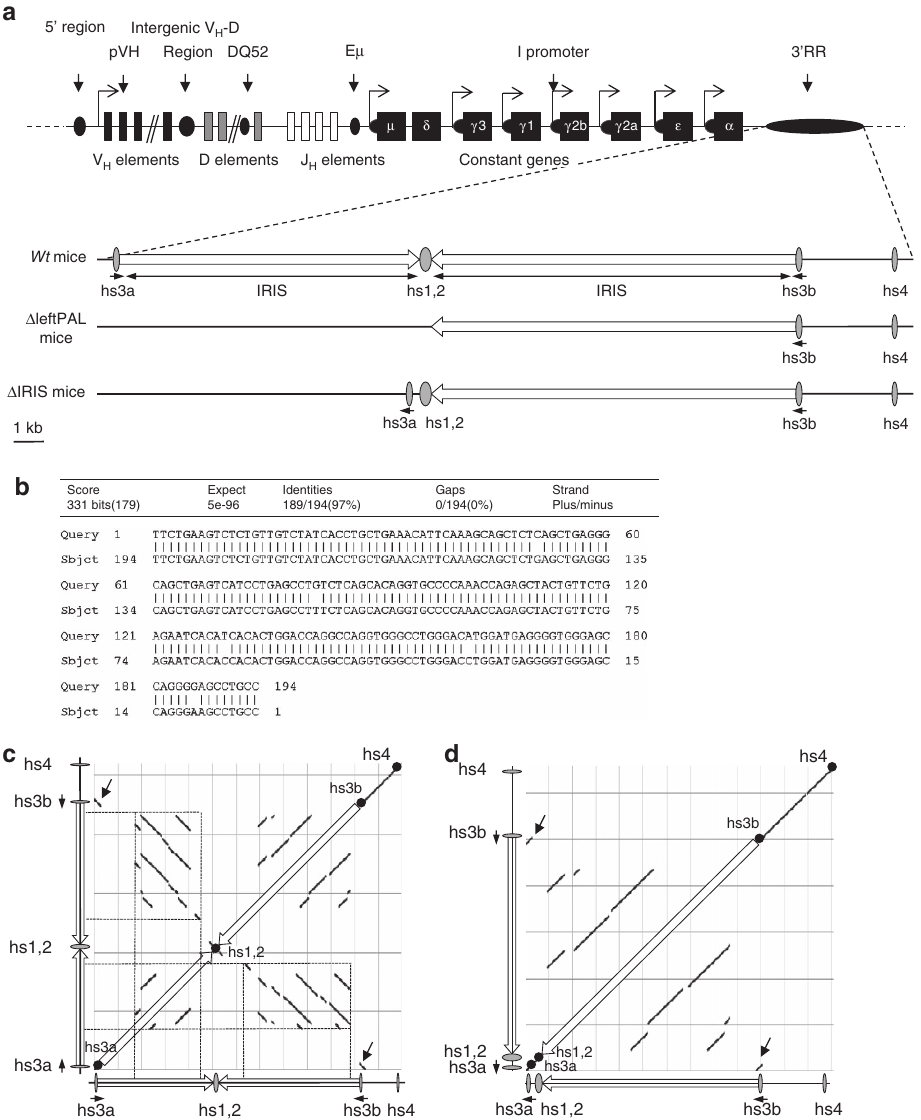
Figure 1 | Palindromic structure of the IgH 3’RR . ( a ) Upper part: The mouse IgH locus (not on the scale). Lower part: The 3’RR with its four enhancer elements and the IRIS (on the scale). D leftPAF and D IRIS mice are represented. ( b ) Sequence and homology between hs3a and hs3b enhancers (in opposite orientation in the chromosome). ( c , d ) DNA sequence dot-plot of the 3’RR in wt ( c ) and D IRIS mice ( d ) showing self similarity. The main diagonal represents the sequence alignment with itself. Parallel lines to the main diagonal represent repetitive patterns within the sequence (that is, tandem repeat), whereas perpendicular lines to the main diagonal represent similar but inverted sequences, thus allowing to identify the palindromic structures (dotted lines). The inversion of hs3a enhancer (black arrows) and the deletion of the intervening sequences between hs3a and hs1,2 in D IRIS mice totally disrupts the palindromic structure, despite the presence of all enhancer